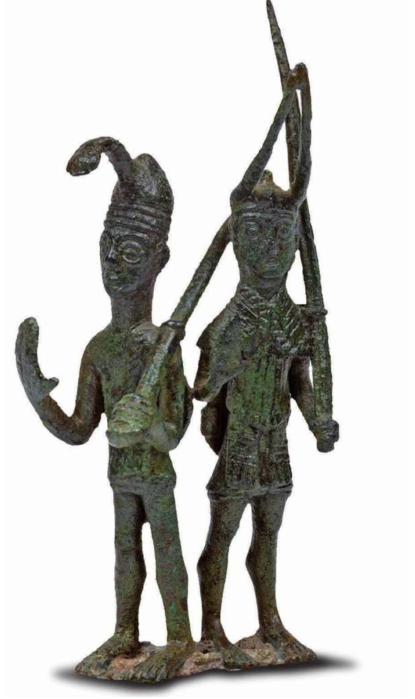
Figure 4. ‘Bronzetti’ from Abini ‘Nuragic’ sanctuary in Teti (from Canino 2014, p.